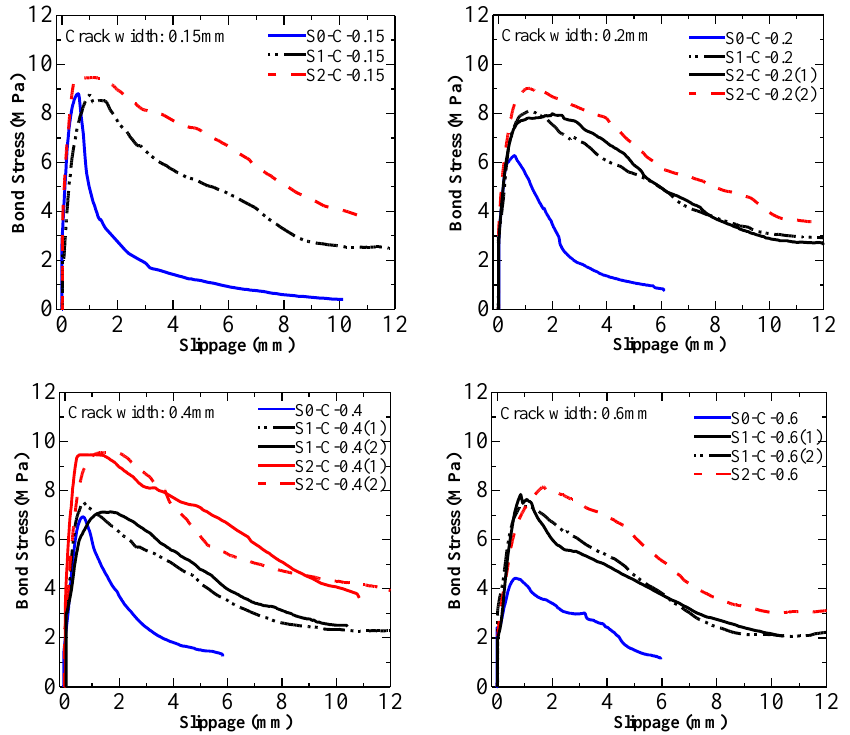
Figure 11. Examples of bond stress versus slippage curves.